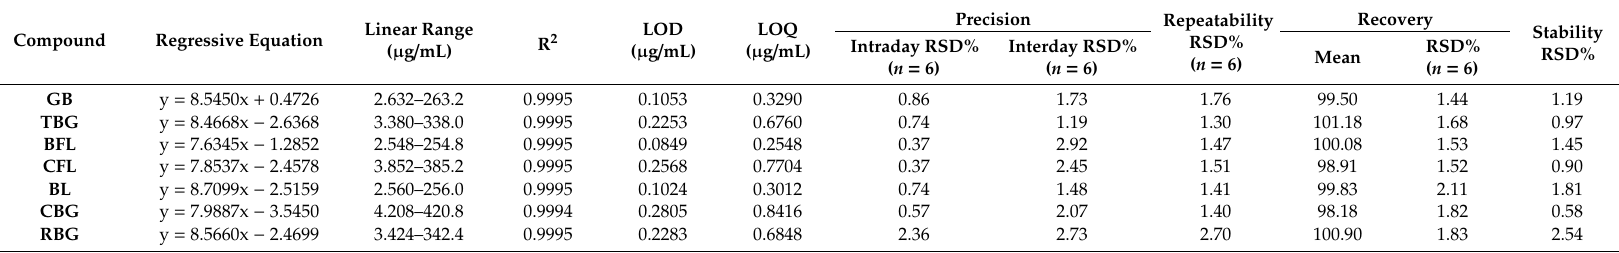
Table 1. Method validation for simultaneous quantification of seven compounds in Chansu. LOD: limit of detection, LOQ: limit of quantification, RSD: relative standard